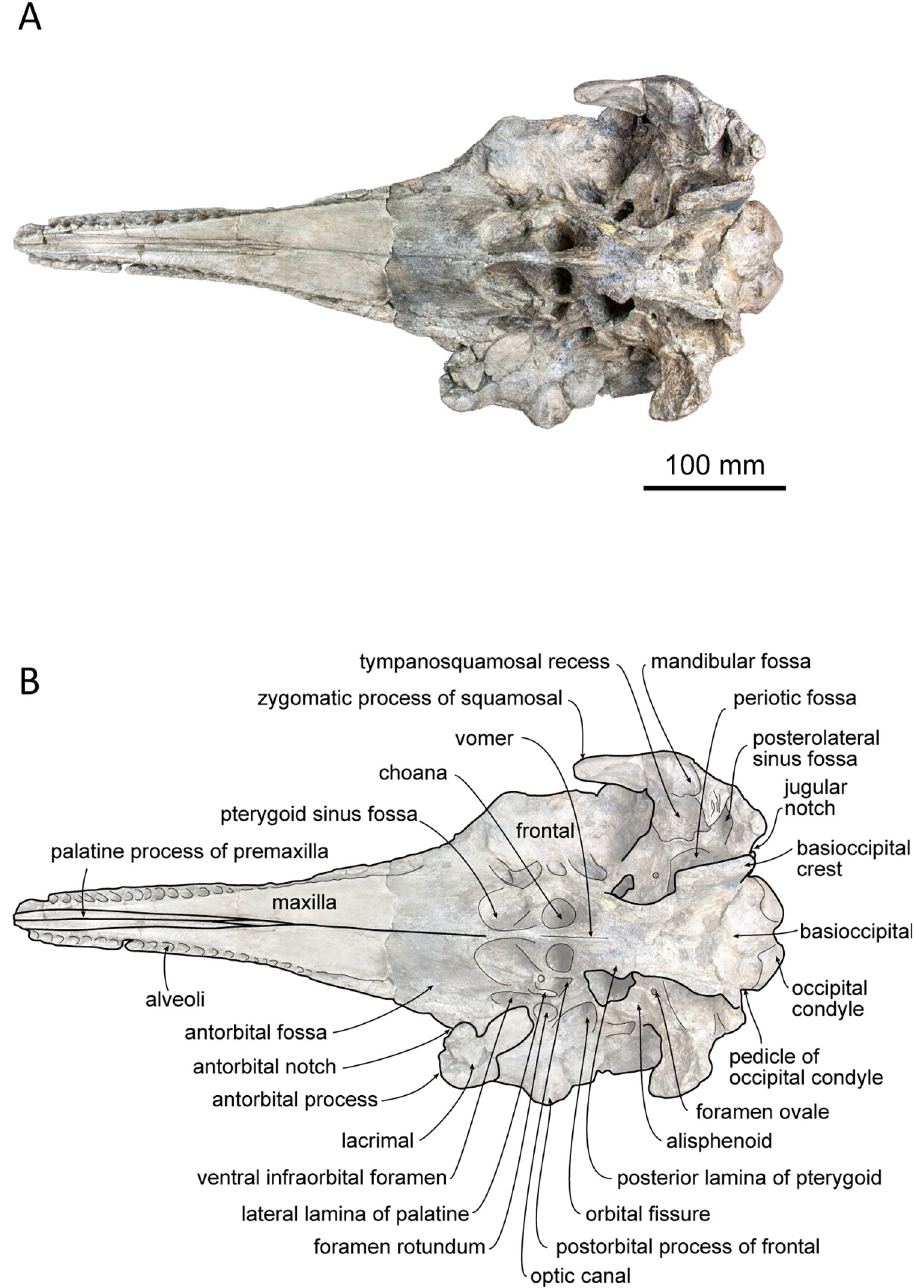
Fig 4. Ventral view of the skull of Platysvercus ugonis gen. et sp. nov., holotype, UTHFM 00034. (A) photo. (B) corresponding line drawing with anatomical interpretations. Scale bar equals 100 mm.